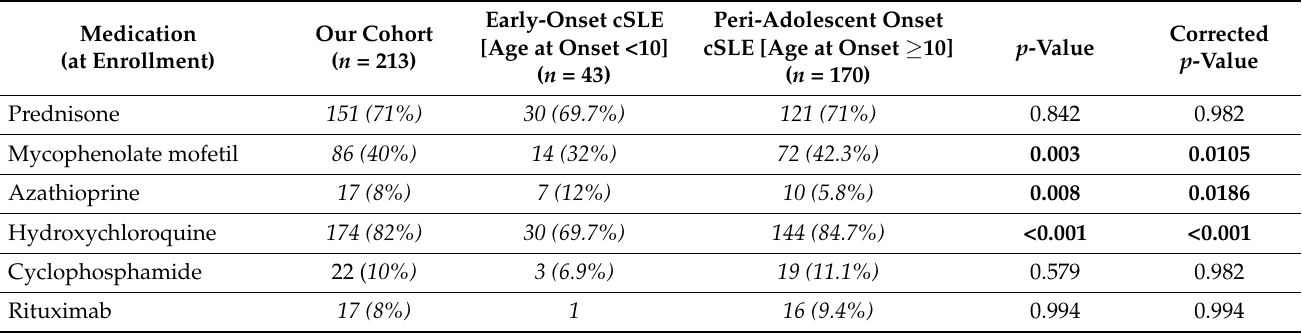
Table 2. Medication Use of Enrolled Subjects with Childhood-onset Systemic Lupus Erythematosus Stratified by Age 2